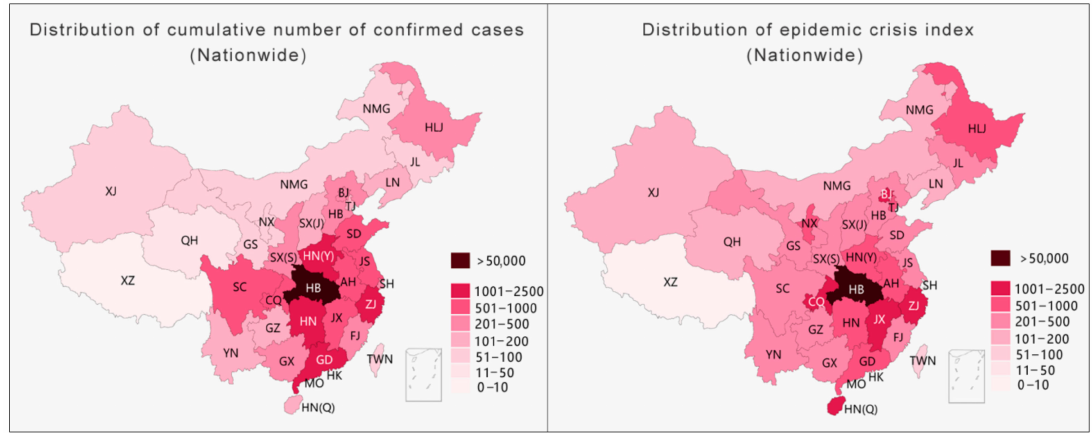
Figure 3. Comparison of the conclusions between the absolute and relative confirmed numbers (as of 22 February 2020). Note: The data on the left came from DXY.cn, accessed on 22 February 2020; the population data on the right are taken from the population statistics of